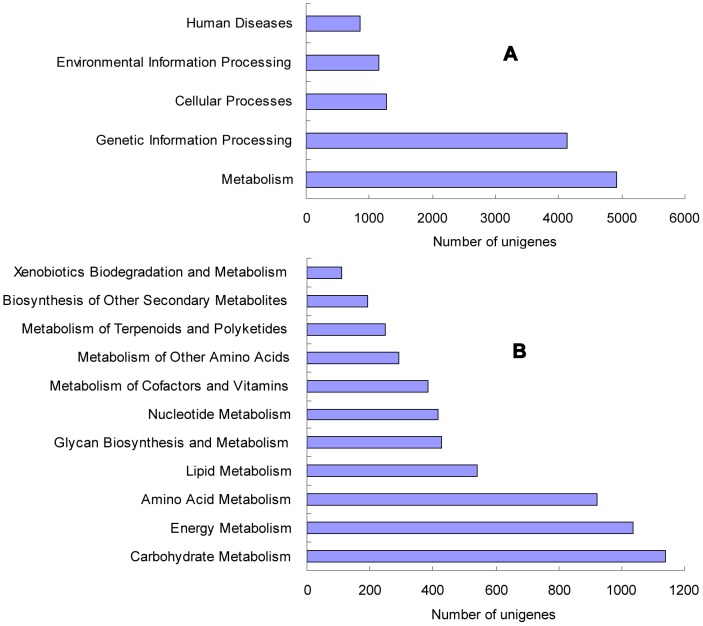
Pathway assignment based on KEGG.(A) Classification based on metabolism categories; (B) Categories classified by KEGG.